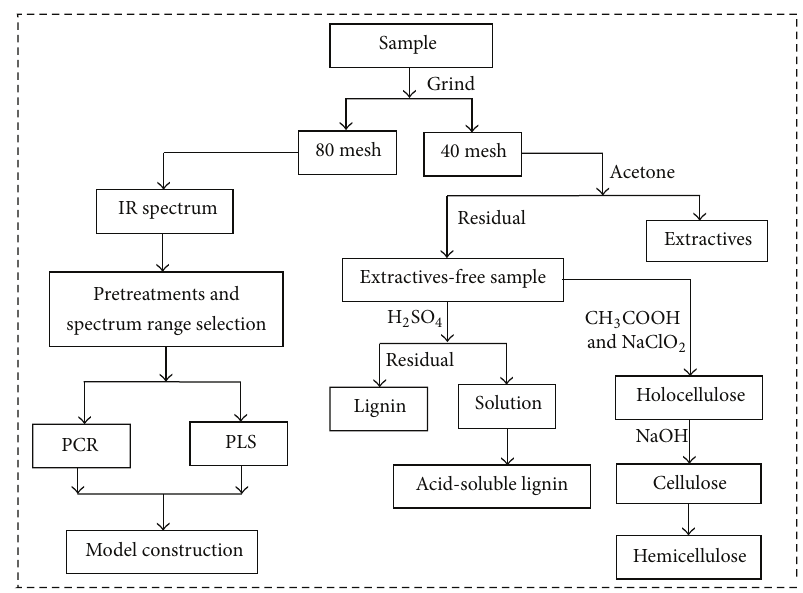
Figure 1: Schematic diagram for the wet chemical and FT-IR analysis